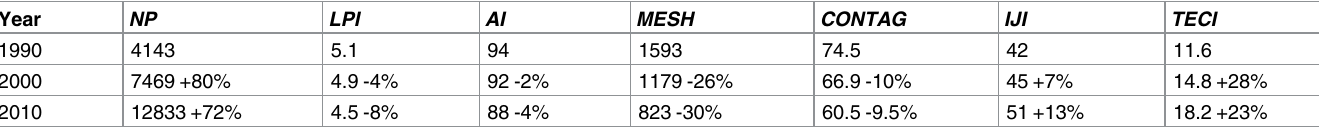
Table 4. Landscape level metricsfor the Chicago